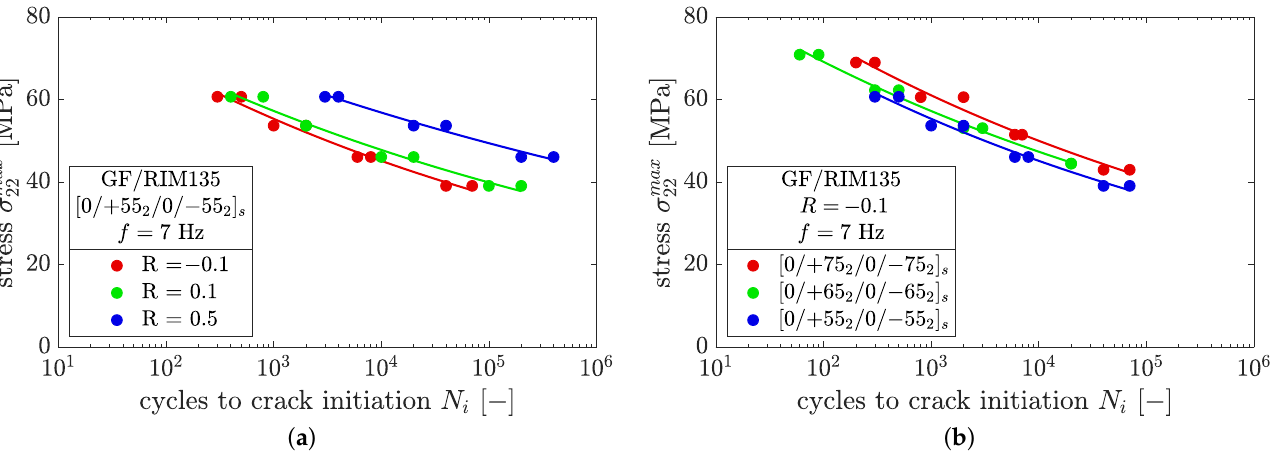
Figure 9. SN-curve for crack initiation in GF/RIM135 laminates in terms of maximum normal ply stress, highlighting the effects of ( a ) different load ratios and ( b ) different fiber orientations.